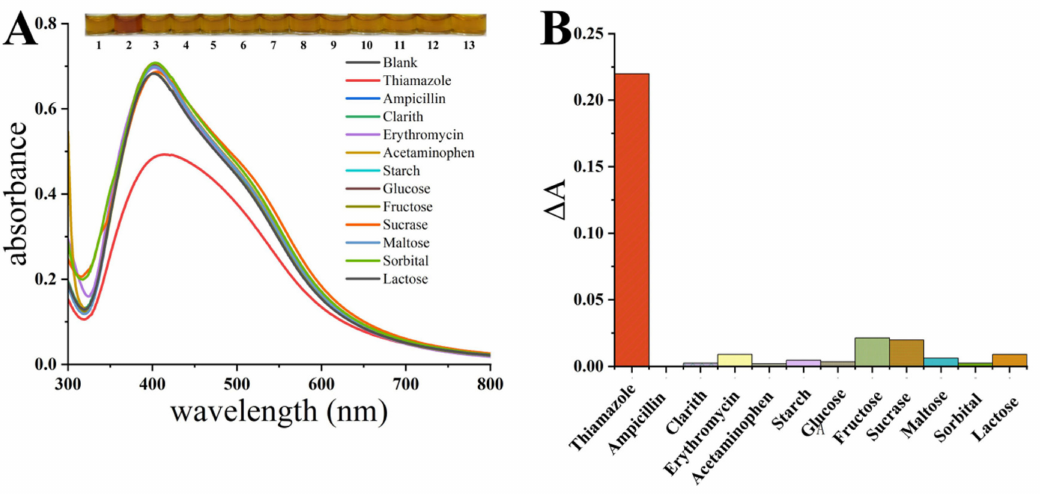
Figure 6. ( A ) The UV-vis spectra of HPS-AgNPs in the presence of different targets; ( B ) the histogram of absorbance in the presence of different targets corresponding to the spectra ( A